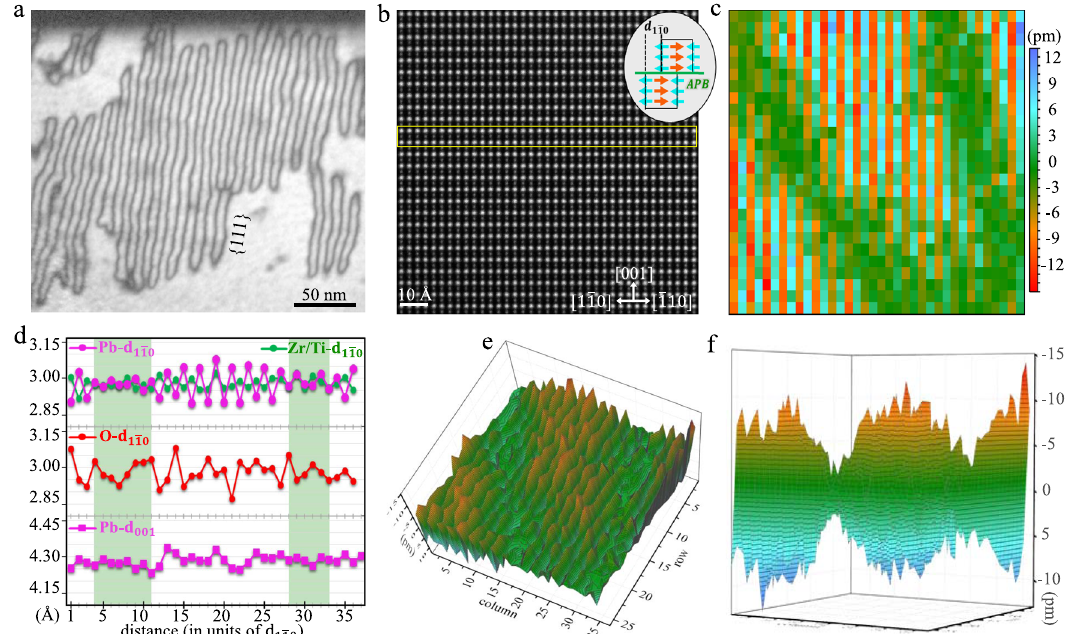
Fig. 4 Antiphase boundaries driven lattice oscillation in PZTN97/3. a Spontaneously assembled APBs with long-period ordering. A large-area view of whole grain is presented in Fig. S5. b , c The atom-resolved HAADF image viewed along [110] p direction and corresponding two-dimensional Pb horizontal displacement mapping, respectively, where the APB manifest itself as a U-like green curve. The inset in b illustrates an ideal model of APB based on antipolar displacement. d Quanti fi ed pro fi les obtained from yellow rectangle box in b show variations of lattice spacing across APBs, which are marked with green background. The O-d 1 (cid:1) 10 pro fi le is calculated from corresponding ABF image in Fig. S8. e , f The 3D views Pb-displacement maps. The projected direction in f is nearly parallel with antiphase Firstly, temperature-induced IP-FE/AFE transition. Figure 6a, c neutron diffraction. Above T c , both PZTN97/3 and PZTN98/2 shows the evolution of crystal structure investigated by in-situ exhibit R-type (see SAED patterns at 400 °C in Fig. 6) and M-type selected-area electron diffraction (SAED) along <110 > p zone (Fig. S9) diffuse superlattice re fl ections. The M-points are obviously weaker than the R-points. Thus, temperature-induced axes. The SAED patterns were acquired with long exposure time phase transition for FE/AFE phase boundary does not start from for visualizing weak re fl ections, which can hardly be observed in